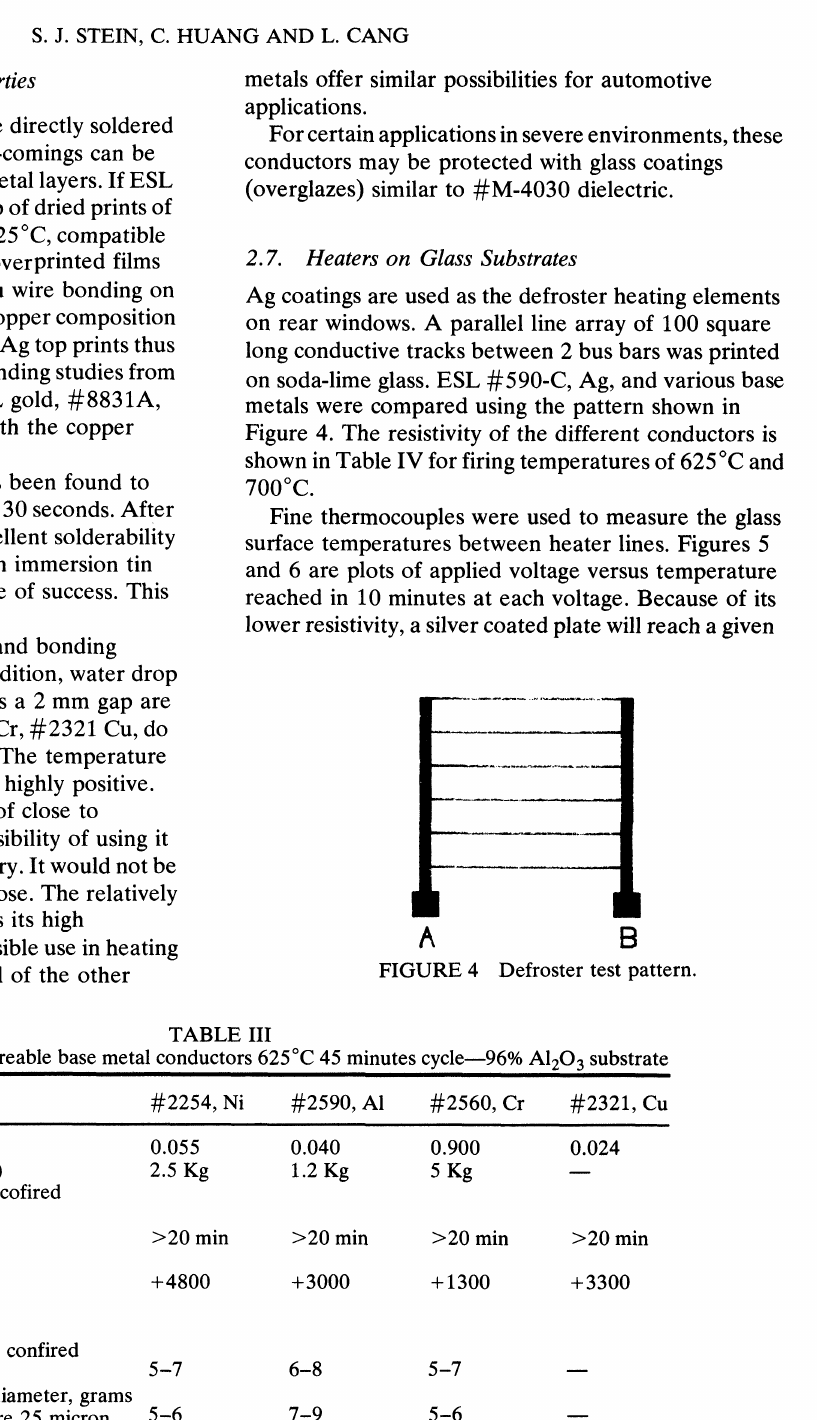
Figure 4. The resistivity of the different conductors is shown in Table IV for firing temperatures of 625C and 700 C.